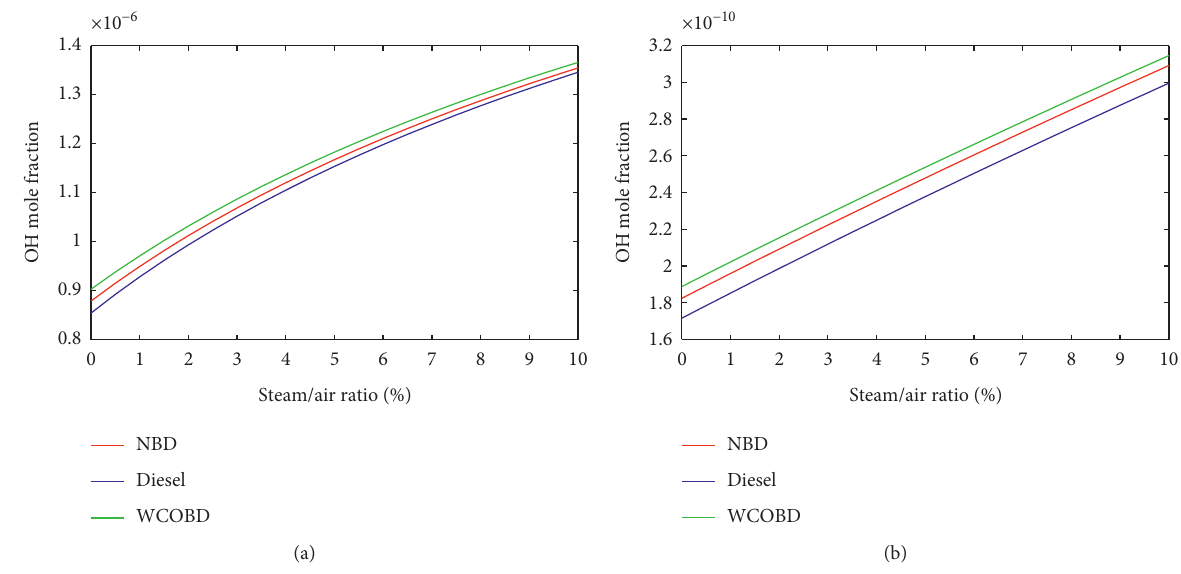
Figure 9: Variation of OH equilibrium mole fractions with steam injection ratios.